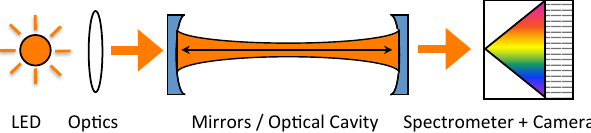
Figure A5. Simplified schematic of the broadband CES instrument.